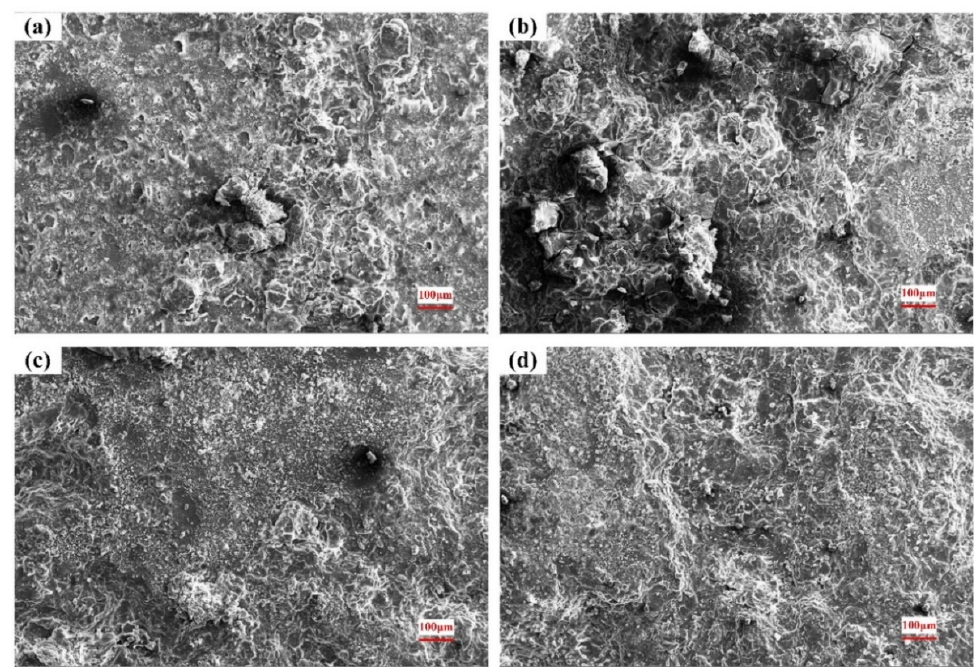
Figure 9. Surface morphology after corrosion in 0.2 mol/L Cl − solution: ( a ) 4 h; ( b ) 8 h; ( c ) 18 h; ( d ) 36 h.